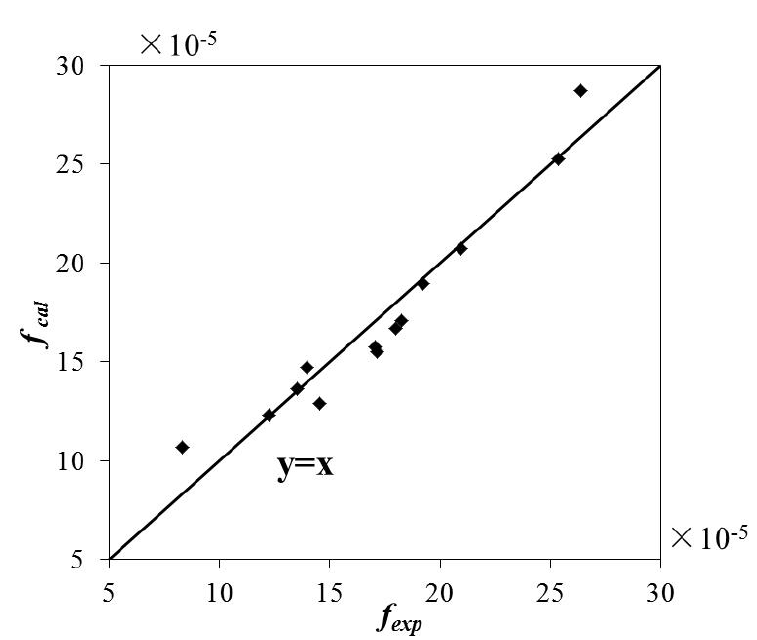
Figure 8. The relationship between f cal and f